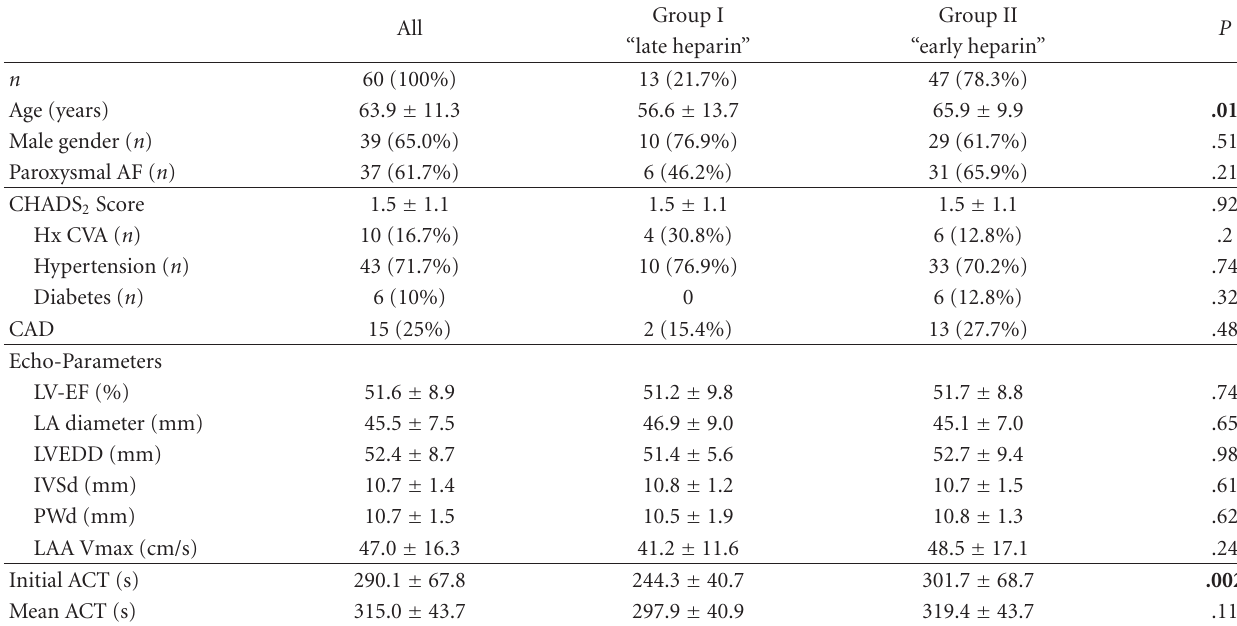
Table 1: Patient characteristics.